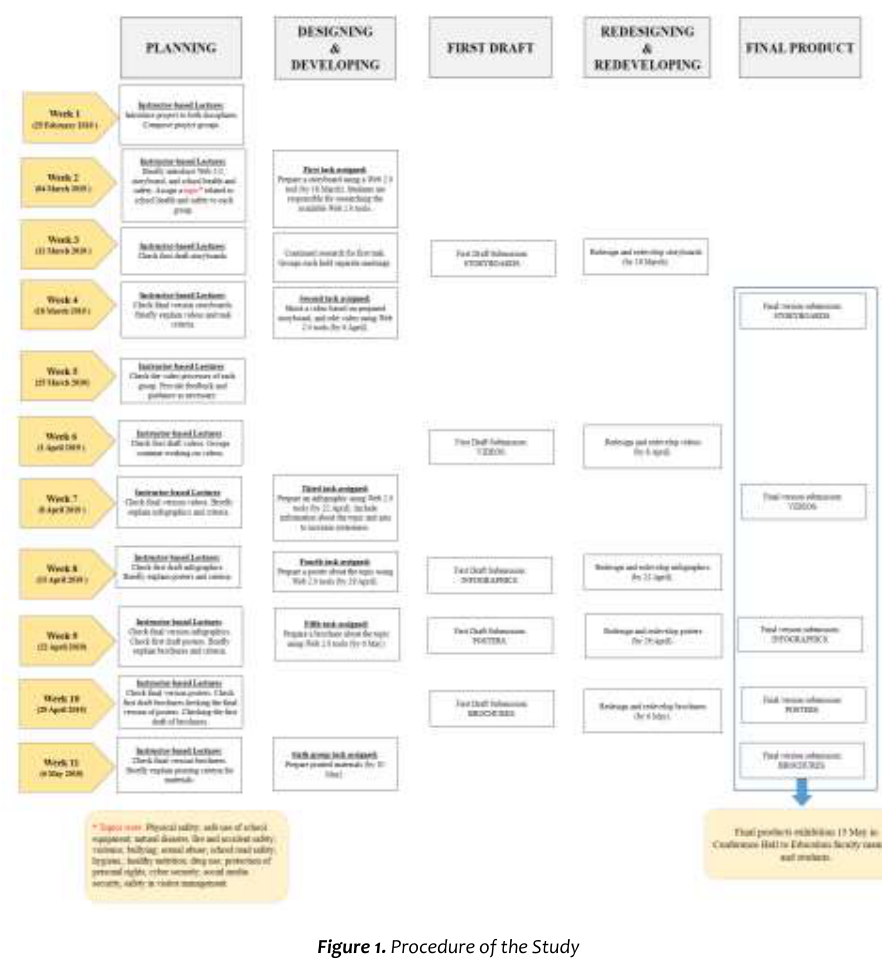
Figure 1. Procedure of the Study